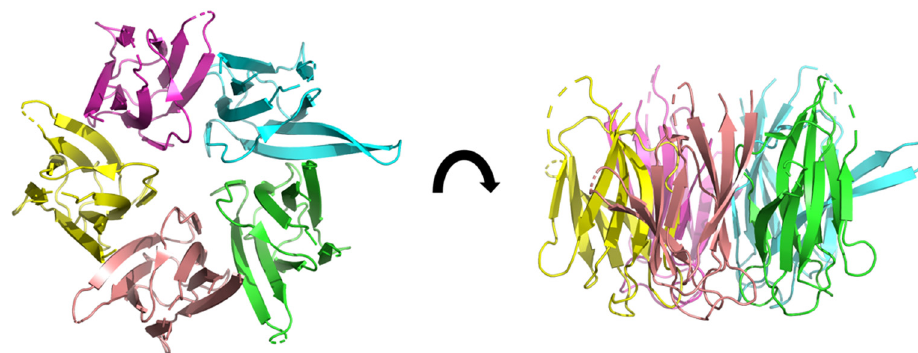
Figure 3. The 3D structure of NP (core domain) from Xenopus laevis , determined by X-ray diffraction at 2.30 Å of resolution (pdb ID: 1k5j) [31]. The five subunits are shown in different colors. Some loops are disordered and appear incomplete (dashed segments).